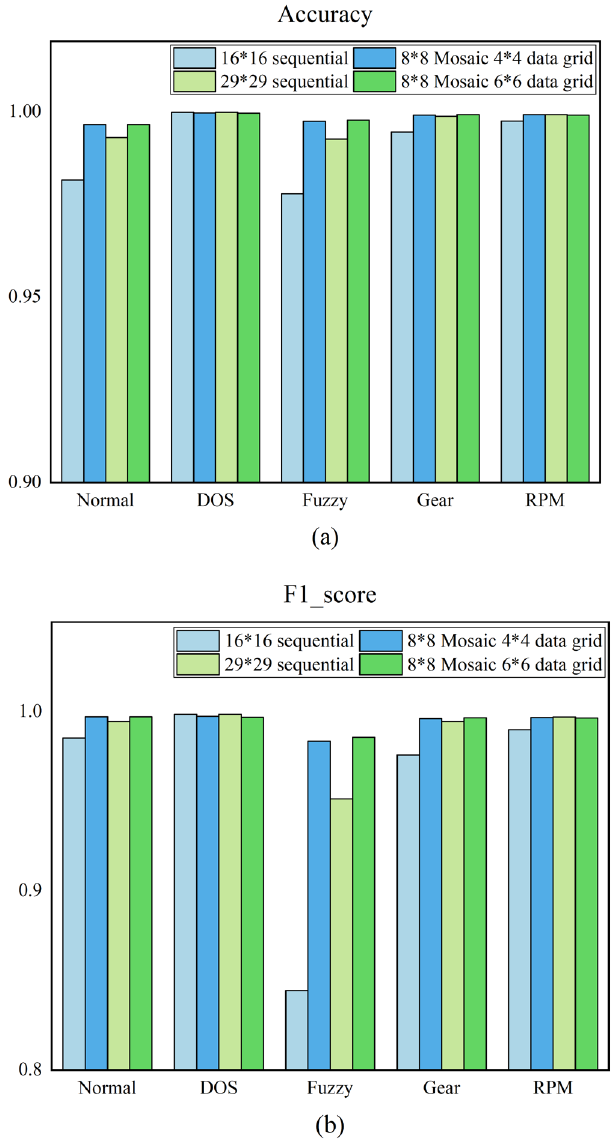
Figure 14. Results of each attack type using different coding methods on dataset no. 1.